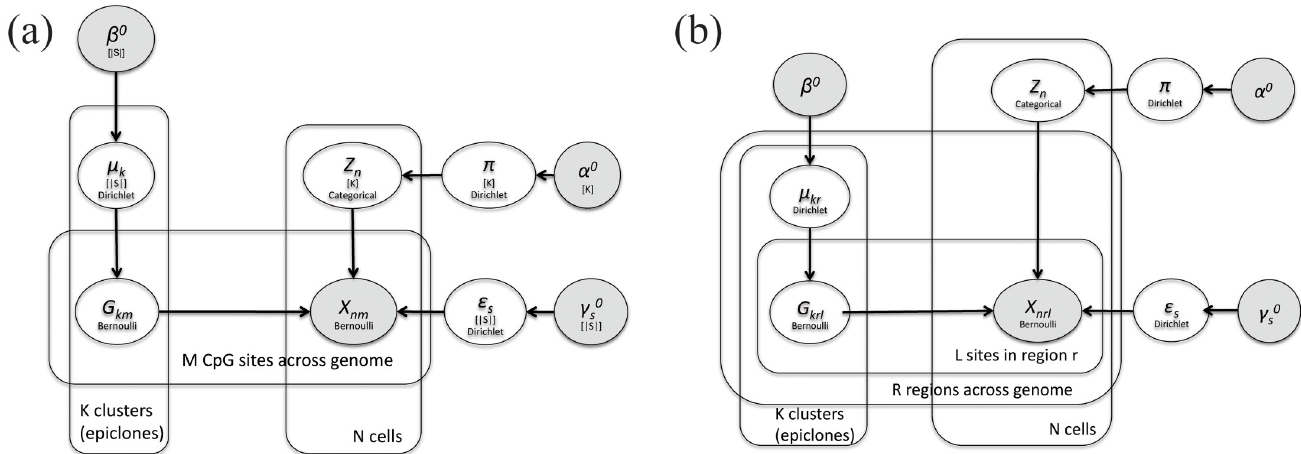
Fig 1. (a) EpiclomalBasic and (b) EpiclomalRegion graphical models. In (a), the shaded node X In (b), we take into account the region location of each CpG and let the shaded node X nrl denote the observed methylation state at CpG site l of region r of cell n . Both X and X take values in S ¼ f unmethylated ; methylated g or simply S ¼ f 0 ; 1 g . In (a) and (b), the unshaded Z nm nrl (with a value in {1, ... , K }) indicating the true cluster population (epiclone) for cell n . The G km and G krl unshaded nodes in (a) and (b) respectively are the latent variables with values in S that correspond to the true hidden CpG epigenotypes for each epiclone k . The unshaded μ , π , and � nodes in both (a) and (b) correspond to the unknown model parameters, which under the Bayesian paradigm have prior distributions with fixed hyperparameters described by the shaded nodes with the 0 superscript. The distribution assumed for each variable or parameter is written within its node. The edges of the graphs depict dependencies. The plates depict repetitions. In EpiclomalBasic (a), true hidden epigenotypes share the same probability distribution across all CpG sites in the same epiclone ( G In EpiclomalRegion (b), true hidden epigenotypes follow a Bernoulli distribution with probability parameters that vary across regions ( G krl � Bernoulli( μ kr )).